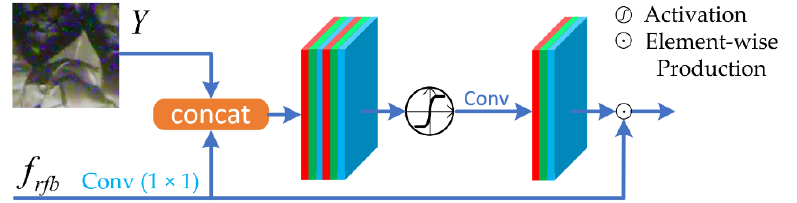
Figure 6. The attention blocks (AB) module. The inputs are the original image patches and the feature maps from the RFB, then they are concatenated with the help of a 1 × 1 convolution. The concatenated maps are followed by a 3 × 3 convolution and a Tanh activation. After feature fusing, an element-wise production is performed between the feature maps from the RFB branch and the Tanh branch, as the output of this attention block.